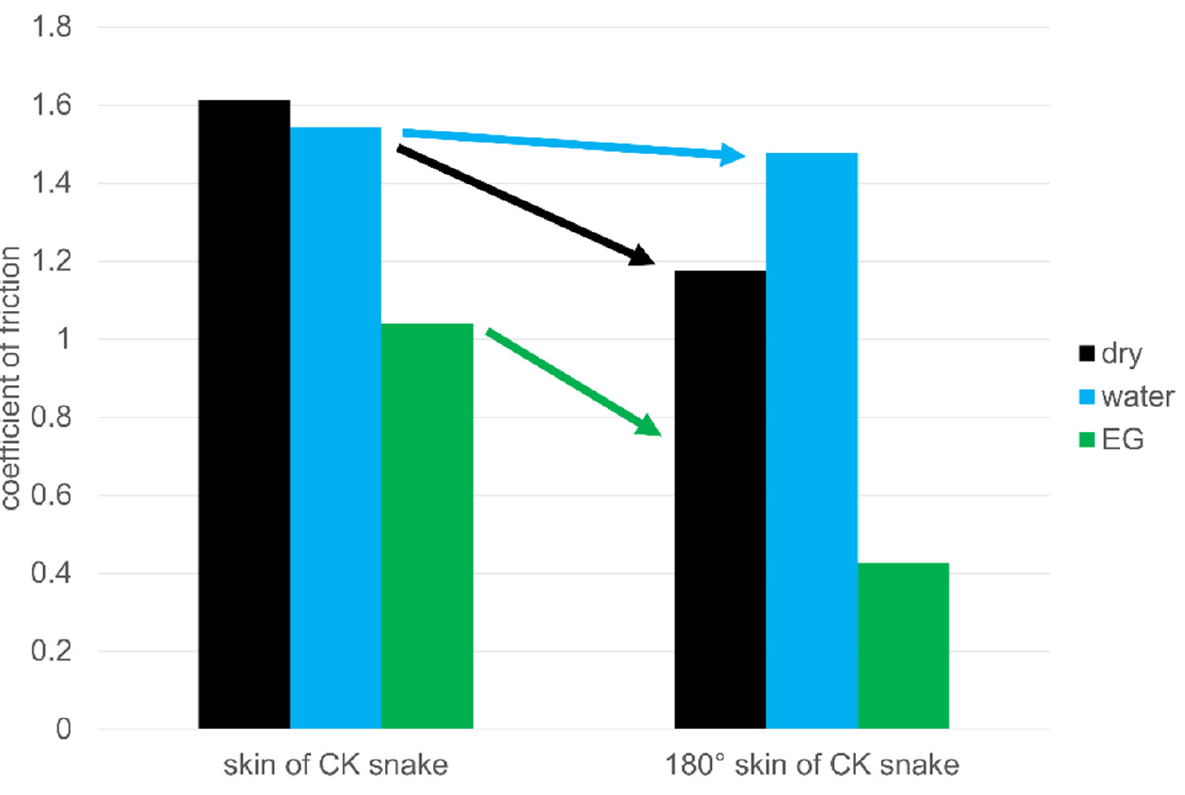
Figure 14. Anisotropic friction values in the examination of real snakeskin molded in LSR as a bioinspired reference